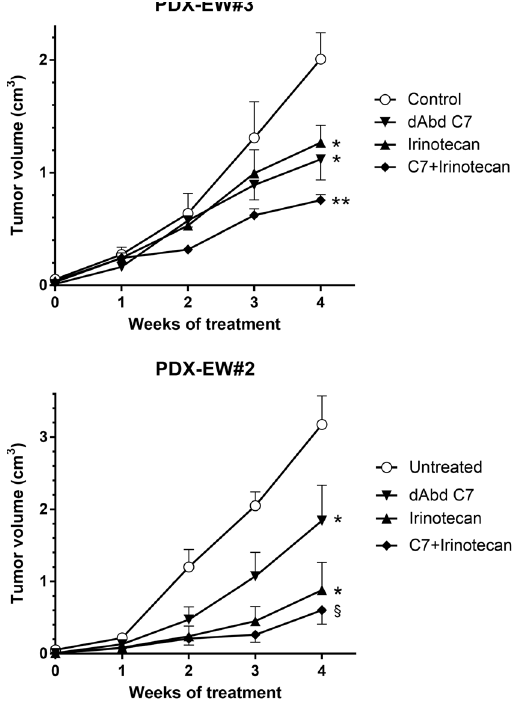
Figure 4. Inhibition of PDX-EW#3 and PDX-EW#2 (as indicated) tumor growth by a combination of anti-CD99 diabody C7 and irinotecan. Groups of 5–6 mice were treated as described under Material and Methods. Statistical comparisons: * slope of linear regression significantly different from untreated, p < 0.05; ** slope of linear regression significantly different from all other groups, p < 0.01 at least; § slope of linear regression significantly different from untreated and from C7, p < 0.01 at least, p = 0.17 versus